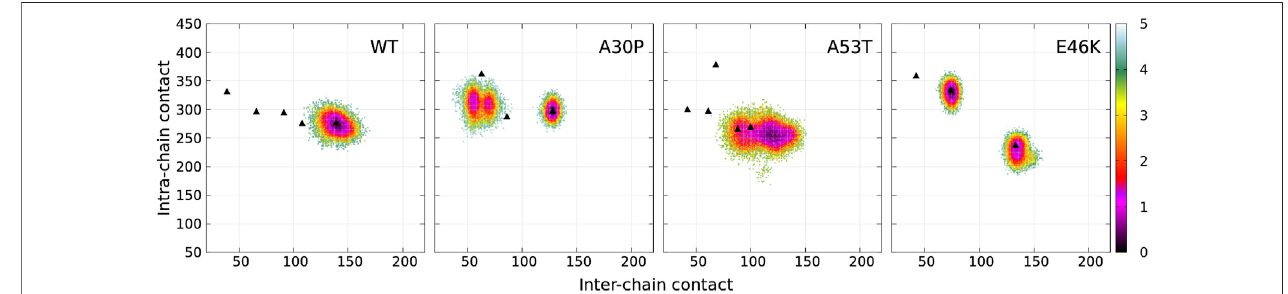
] computed from the 2D probability density function P of the number of inter-chain ( n FIGURE 7 | Color maps of -ln [ P ( n inter , n intra ) P max between the residues of α -syn for the sub-ensemble of dimers with fi bril native contacts found in molecular dynamics trajectories at 300 and 310 K of the WT and variants. In each map, P max is the maximum value of the probability of the map. The local minima numbered in Figure 1 are shown by black